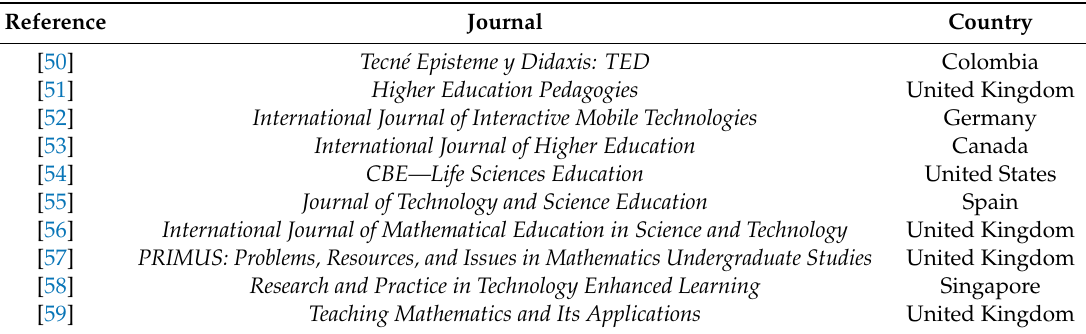
Table 2 . Journals to which the works belong and country . Table 2. Journals to which the works belong and